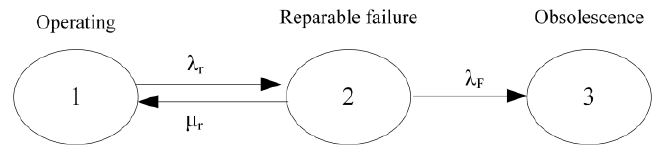
Fig. 2. Markov chain model considering aging effect